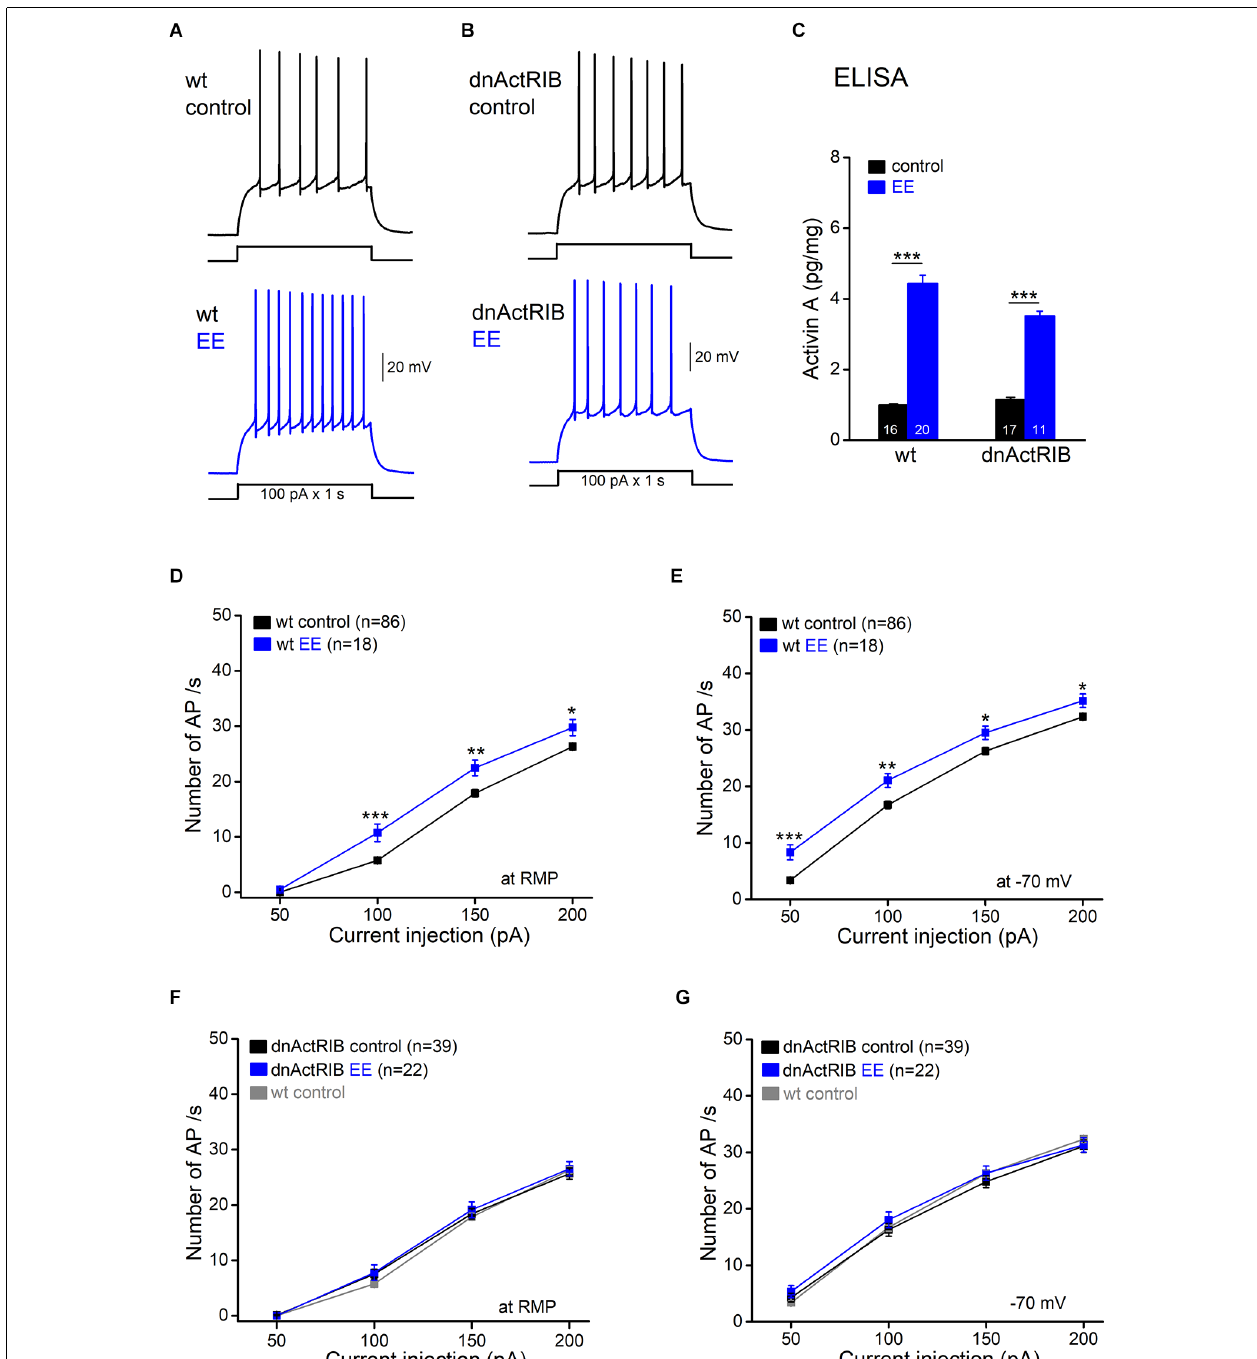
FIGURE 1 | Excitatory effect of enriched environment (EE) on dentate gyrus granule cell firing is blocked in dnActRIB mice. (A,B) Whole-cell current-clamp recordings from granule cells from wild-type (wt; A ) and dnActRIB (B) mice with and without overnight (12 h) EE housing illustrate the repetitive action potentials (APs), evoked at resting membrane potential (RMP) by injecting depolarizing current (100 pA for 1 s). (C) Enzyme-linked immunosorbent assay (ELISA) analysis reveals elevated level of activin A protein in both wt and dnActRIB hippocampi. A comparison between mice housed in control cages and those experiencing overnight EE revealed strongly enhanced levels of activin A in the hippocampus of the latter (wt control, 0.99 ± 0.03 pg/mg; wt EE, 4.44 ± 0.26 pg/mg; p = 2.67e -15 ) (dnActRIB control, 1.15 ± 0.04 pg/mg; dnActRIB EE, 3.52 ± 0.13 pg/mg; p = 1.09e -11 ). Numbers in columns indicate sample size. (D,E) Plots of action potential (AP) discharge upon depolarizing pulses summarize the EE-induced enhancement in granule cell firing at RMP (D) and at a holding potential of -70 mV (E) . (F,G) EE fails to change granule cell firing in dnActRIB mice. Data from wt controls (in gray) were replicated here to illustrate the unaltered excitability of dnActRIB granule cells. * p < 0.05, ** p < 0.01, *** p < 0.001.